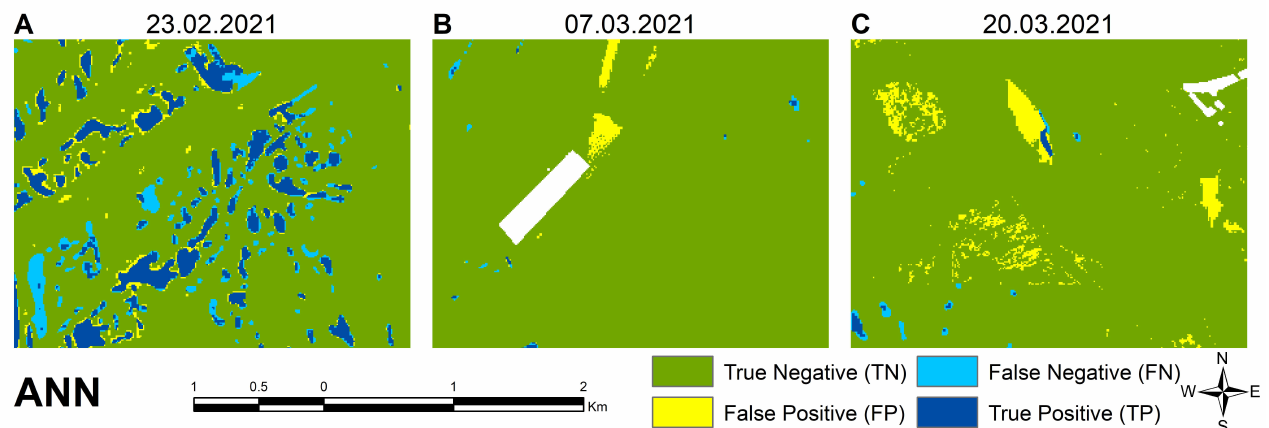
Figure 15. Examples of artificial neural network model classification errors at different times, in ‐ cluding ( A ): Relatively small omissions 23 February 2021; ( B ): some overclassification 20 March 2021; and ( C ): some overclassification due to atmospheric disturbances 20 March 2021.